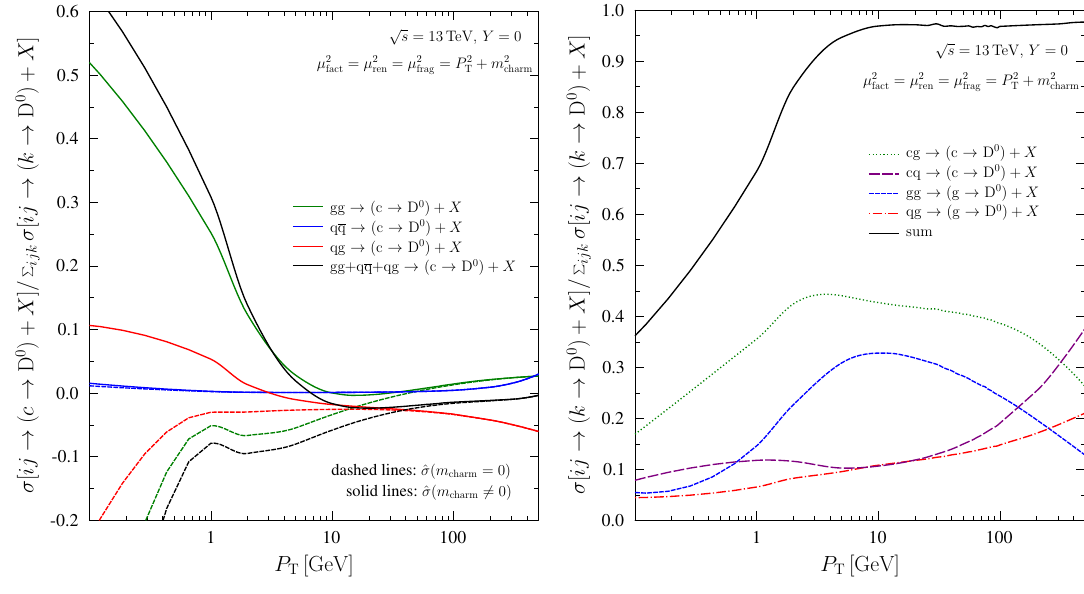
Figure 2 . Left-hand panel: contributions of light-parton-to-heavy-quark processes normalized to the full result including all the channels. The solid curves correspond to the complete GM- VFNS calculation and the dashed curves are from a calculation with zero-mass matrix